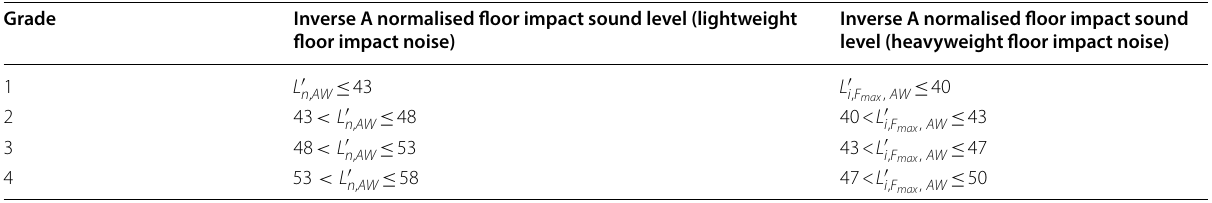
Table 7 Standard level of floor impact sound insulation (unit: